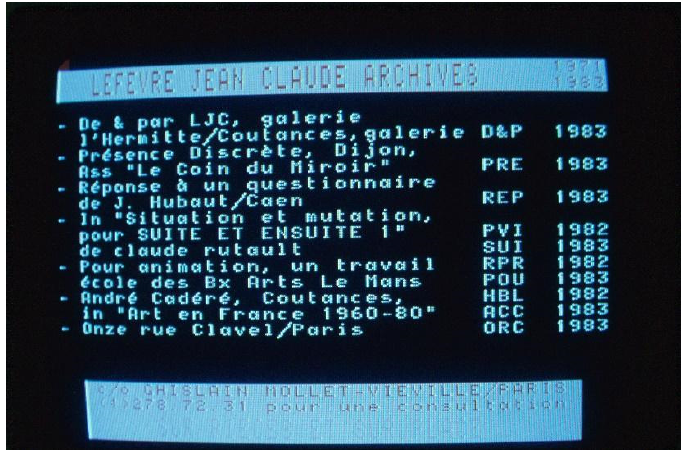
Figure 7. Image from “Lefèvre Jean-Claude Archives 1971–1983”, project by the artist Lefèvre Jean- Claude for Art Accès . Collection Les Immatériaux © Kandinsky Library, MNAM/CCI, Centre Jean-Claude for Art Acc è s . Collection Les Immat é riaux © Kandinsky Library, MNAM/CCI, Centre Pompidou.